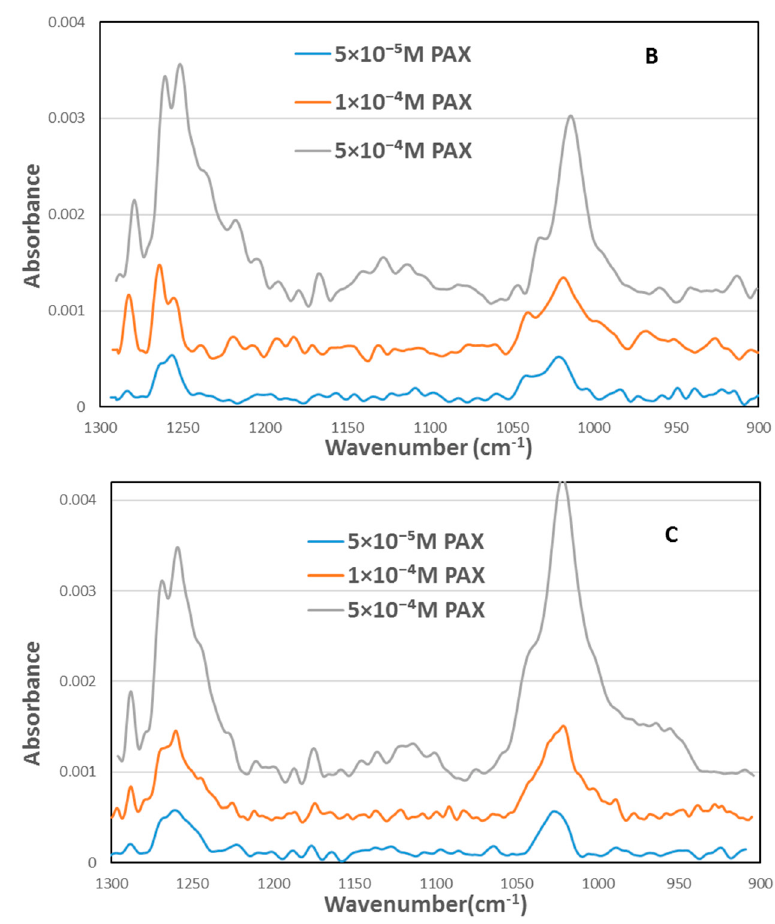
Figure 3. Fourier transform infrared (FTIR) spectra of chalcopyrite surface after treated with different PAX solutions for 2 h at ( A ) 25 °C; ( B ) 40 °C; ( C ) 60 °C.